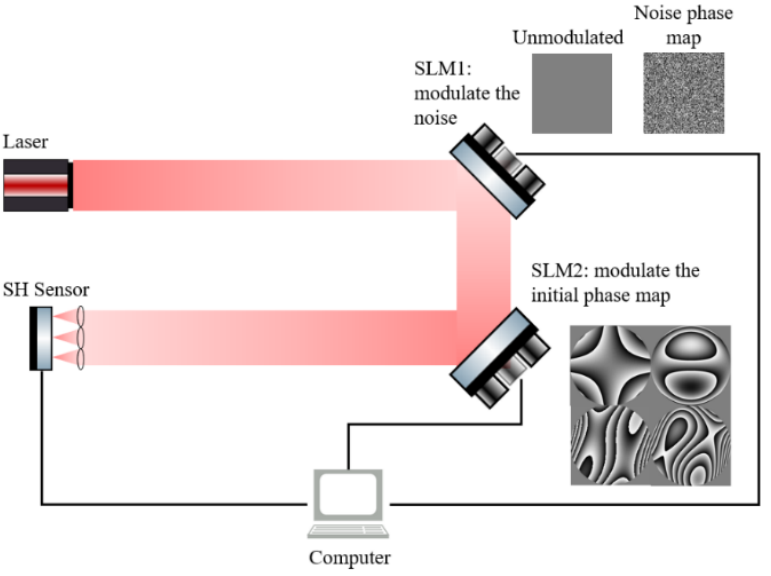
Figure 12. The schematic setup of phase unwrapping based on the SH sensor. One spatial light modulator (SLM1) is used to modulate the noise; another spatial light modulator(SLM2) is used to modulate the initial phase map. SH sensor is used to capture the modulated phase map. The imagesfor different initial phasescaptured by SH sensor are given in Figure